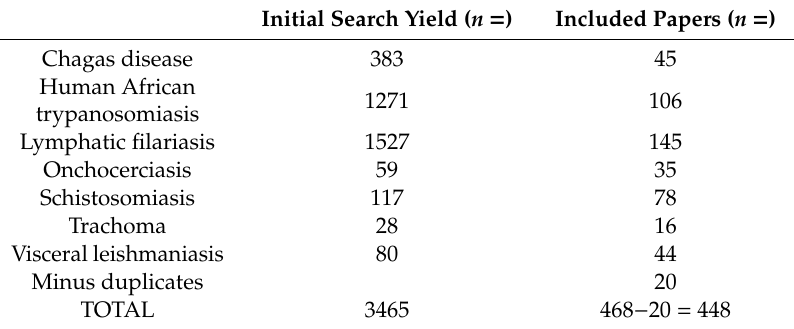
Table 2. Scoping review results in aggregate and by